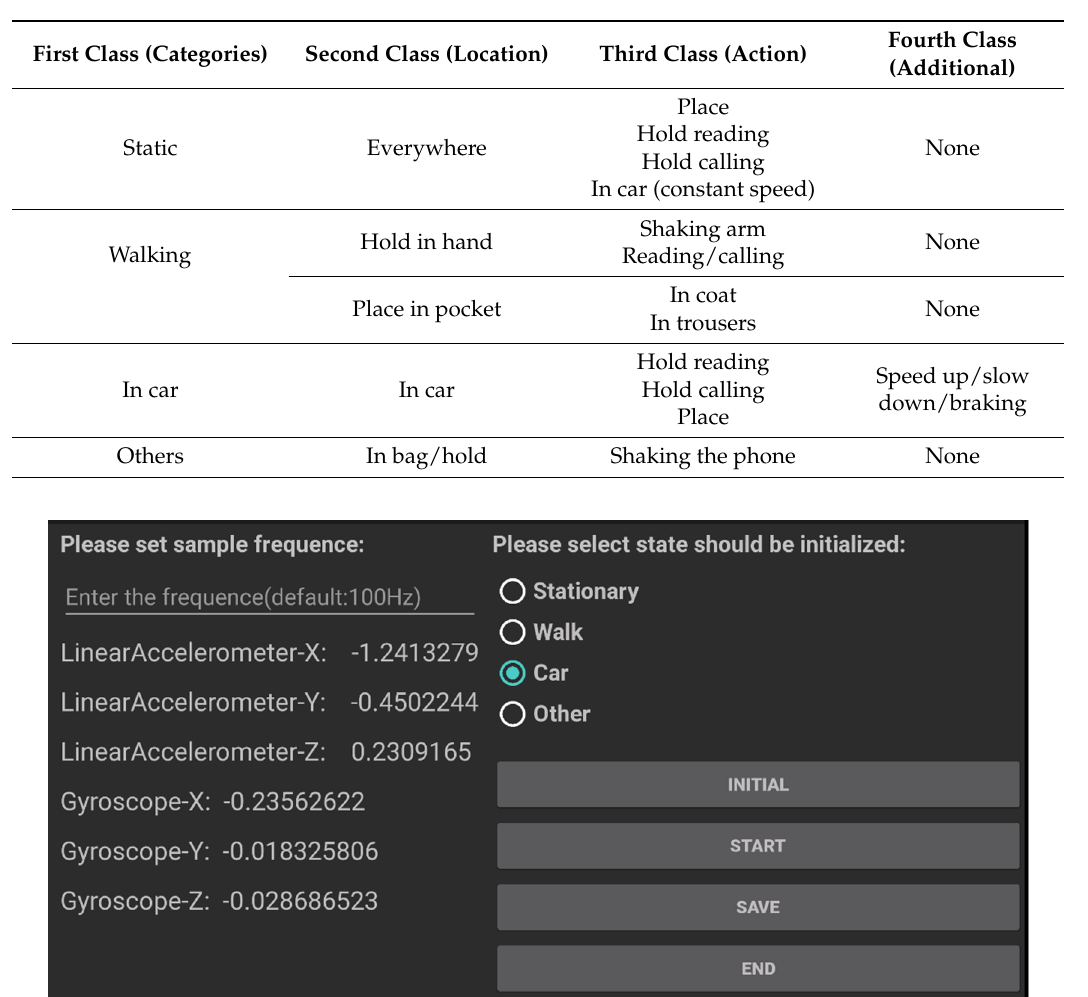
Table 2. Data collection types.